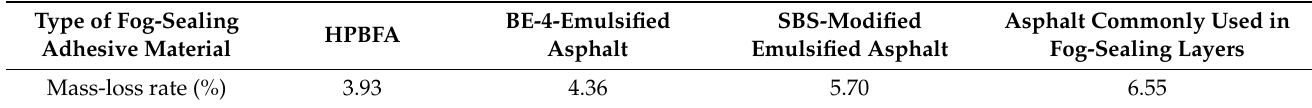
Table 7. Mass-loss rate of the specimens after photothermal aging.